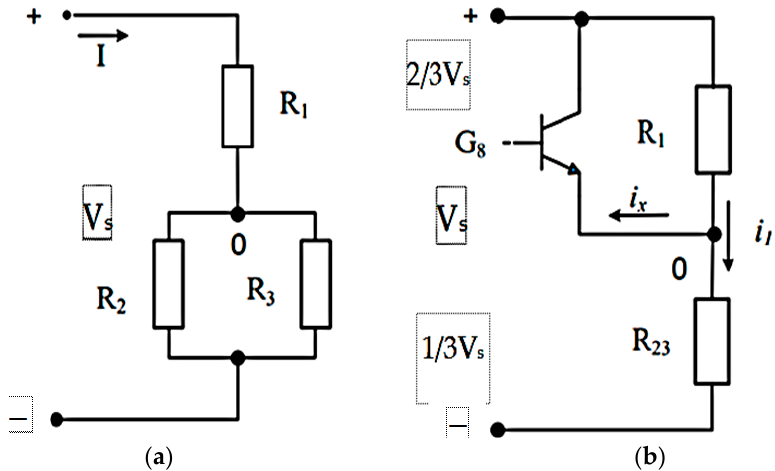
13 of 19 Figure 6. Diagram of the implementation of the symmetry device. The implementation principle is based on: G 1 –G 6 are main power valves of voltage; G 7 and G 8 are additional valves of voltage symmetrization; R 1 –R 3 are load resistances; VS is a sensor of neutral voltage about «—» bus of power supply; SVSR is a system of valve switching rate; VCPD is valve control pulse distributor; CPVSS is a system that sets the voltage of common point, and DCR is the discrete current regulator. The operation principle of the system is the following. The value of valve switching rate f s = 300 Hz is set by the SVSR and is transmitted to the VCPD, which creates valve control pulses with a frequency of 50 Hz and a duration of 180 degrees. This results in a three-phase voltage on the inverter output. When the operation is symmetrical, then the common point neutral about «—» changes from 0.33 Vs to 0.66 Vs. Since potential changes periodically from one period to another then it can be assumed that potential is high on even periods and low on odd periods. One of the outputs, VCPD pulses, for example, x 1 , is taken as the time reference point. Then it becomes possible to set common point voltage V vp on all periods using the CPVSS. If the load is asymmetrical, then the form of the signal at the neutral point V NP would change. When the difference between voltages V vp and V NP is found, the DCR can be used to transmit a current that would compensate asymmetry with signals x 4 , y 4 . A regulator can be based on the proportional- integral control law [41]. The DCR sends a signal to valves G 7 and G 8 , thereby changing the relative pulse duration of voltage. When the frequency is high, these valves and the DCT make the current source. The proposed implementation of the symmetry device (Figure 6) is based on the